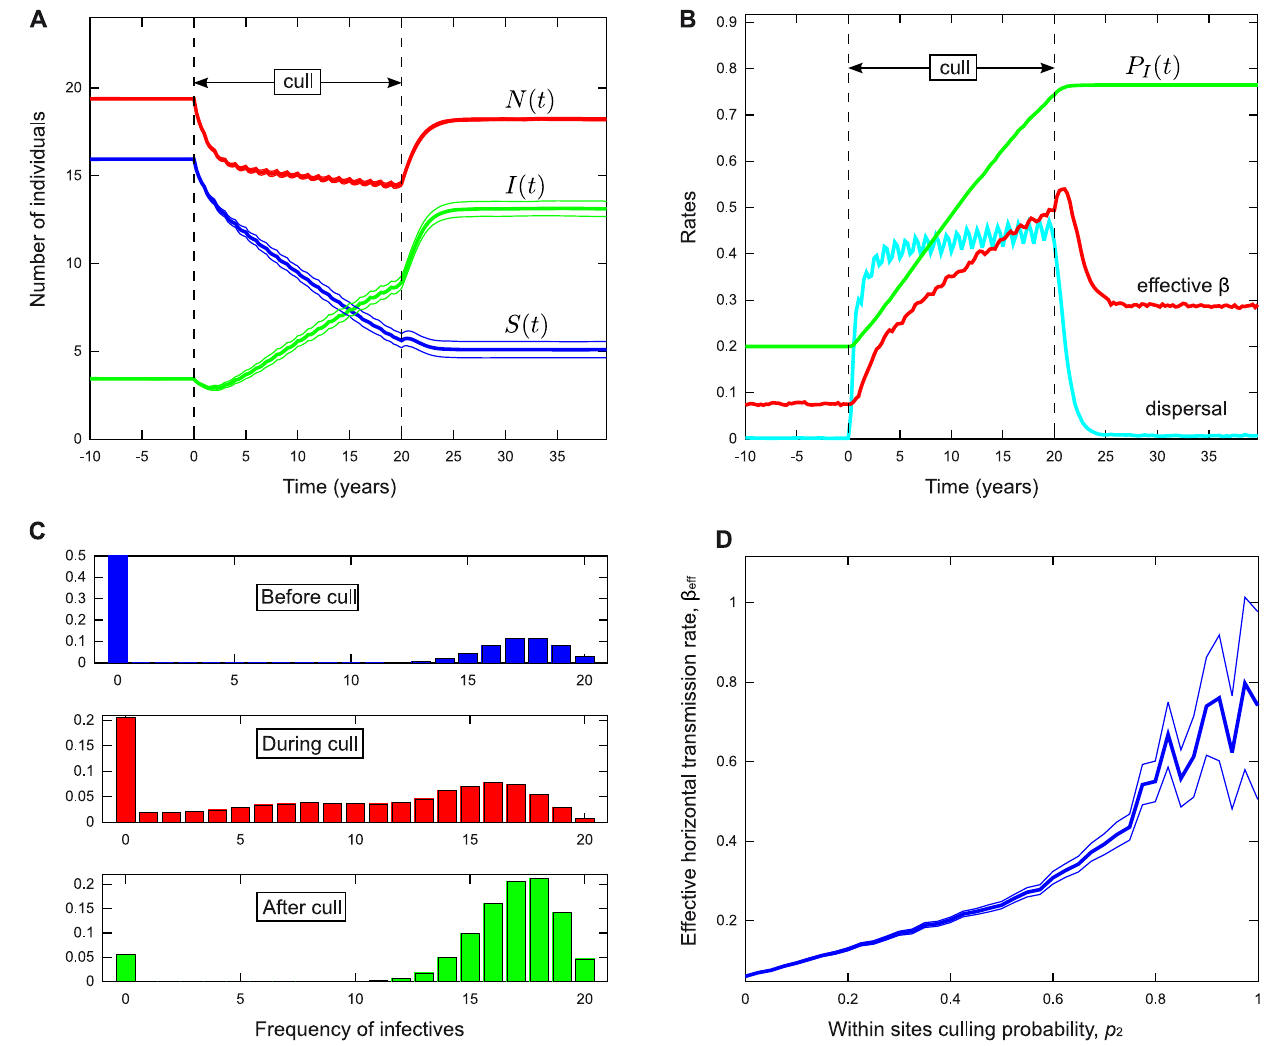
Figure 3. Time trajectories and heterogeneity for emergent disease in the stochastic model. (A) Population numbers, S ( t ), I ( t ), and N ( t ). (B) Proportion of sub-populations containing infectives, P I ( t ) , effective transmission rate b , and dispersal rate. (C) Distribution of I across sites. (D) Effective transmission rate b for disease transmission vs population reduction coverage p 1 . Parameters are given in Table 2, and initial conditions are at the disease free equilibrium f S , I g ~ f 20,0 g , while in 20% of sites randomly chosen, a single individual is infected, resulting in f S , I g ~ f 19,1 g . Population reduction occurs annually from years 50–69, and in p 1 ~ 20% of sites (chosen randomly each year) the removal rate is set to p 2 ~ 1 : 0 , without regard to disease status (equivalent to an overall culling rate of p ~ 0 : 2 ). An initial reduction in I is rapidly replaced by an increase, which is due to the increased chance of invasion of naı¨ve groups by infectives due to the density dependent dispersal. The CI for the effective transmission rate increases for large p 1 due to the increasing number of simulations where the disease becomes extinct.